Question: Compose a caption that would accompany this figure in a paper.
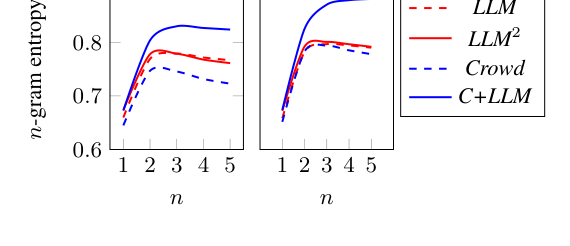
Answer: Entropies of n-gram distributions in un- RocStories (left) and un-SocialIQA (right), computed on the development sets of each data subset.